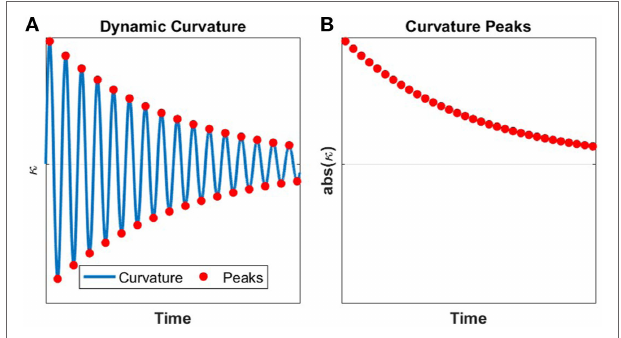
FIGURE 2 | Schematic representation of identification of curvature local extreme values used in NCR Method: (A) Dynamic curvature response and (B) the associated peak curvature